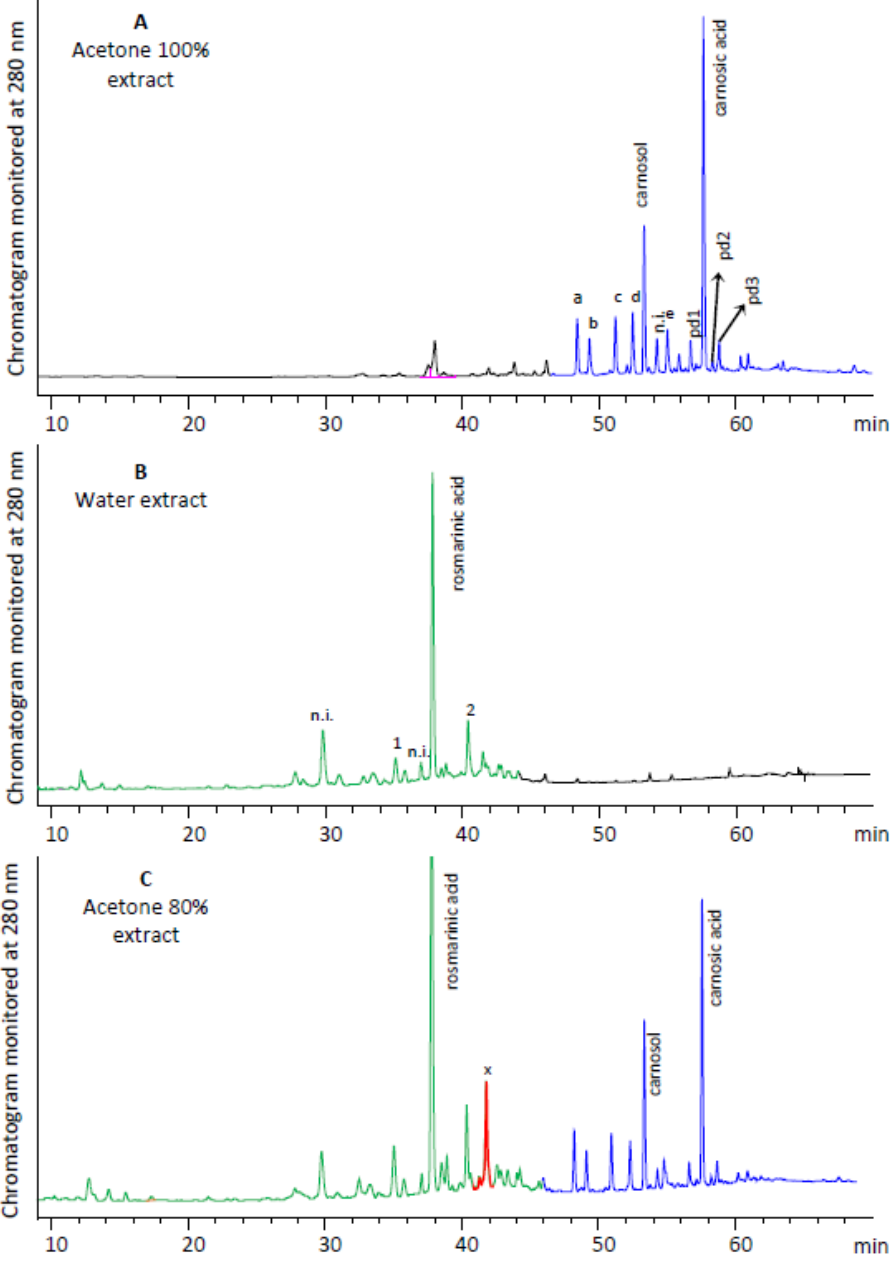
Figure 5. The HPLC-DAD chromatograms of acetone 100% ( A ), water ( B ), and acetone 80% ( C ) extracts, monitored at 280 nm. Blue color indicates the less polar compounds extracted by acetone. Green color indicates the polar compounds extracted by water. Red color corresponds to the compound extracted only by acetone-water mixtures.